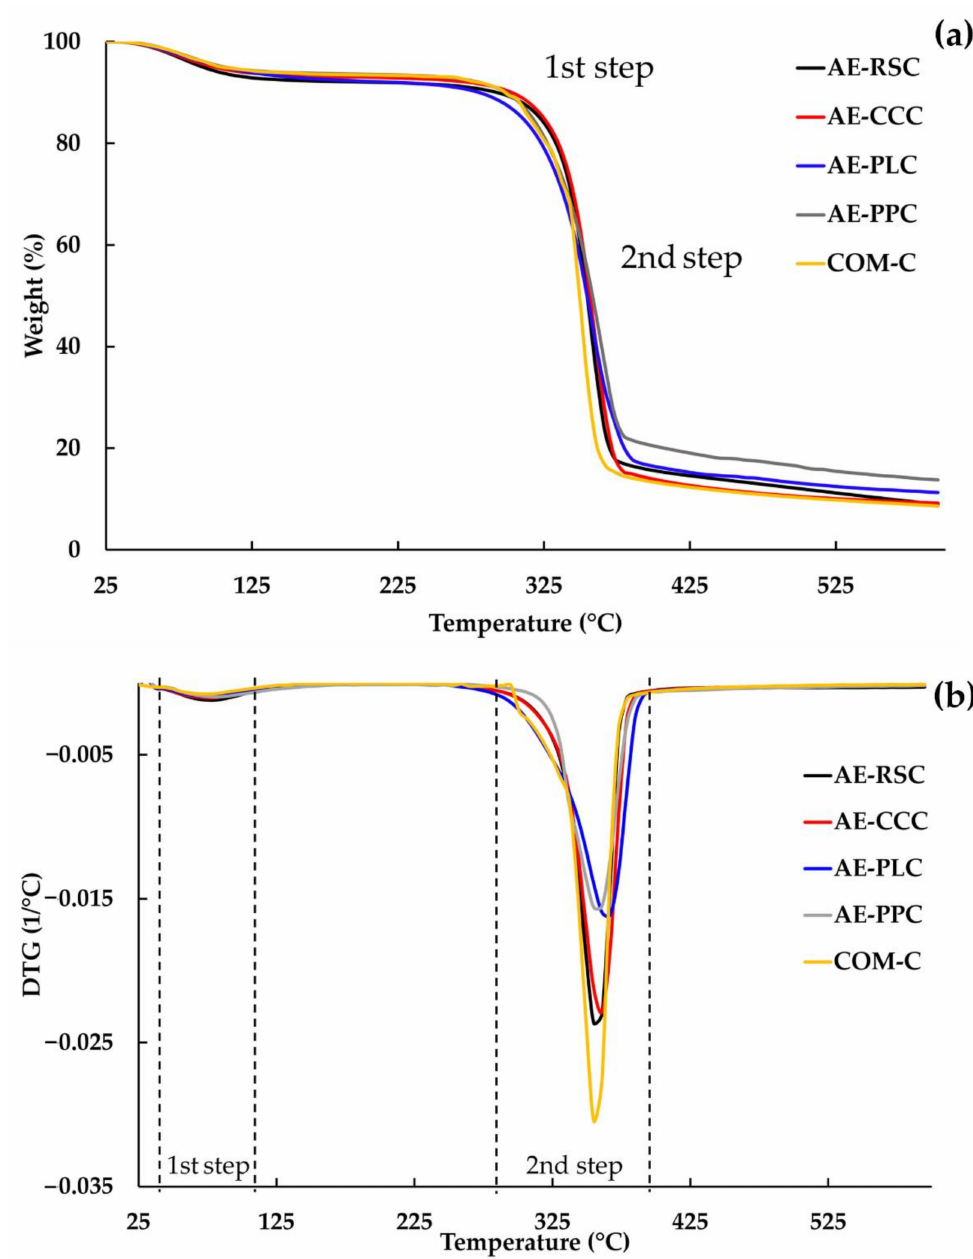
Figure 4. ( a ) Thermogravimetric analysis (TGA), and ( b ) derivative thermogravimetry (DTG) curves of cellulose samples extracted with alkaline processing of agricultural waste materials and their comparison with the commercial cellulose. AE-RSC: alkaline extraction of rice straw cellulose; AE-CCC: alkaline extraction of corncob cellulose; AE-PLC: alkaline extraction of pineapple leaves’ cellulose; AE-PPC: alkaline extraction of pineapple peels’ cellulose; and COM-C: commercial